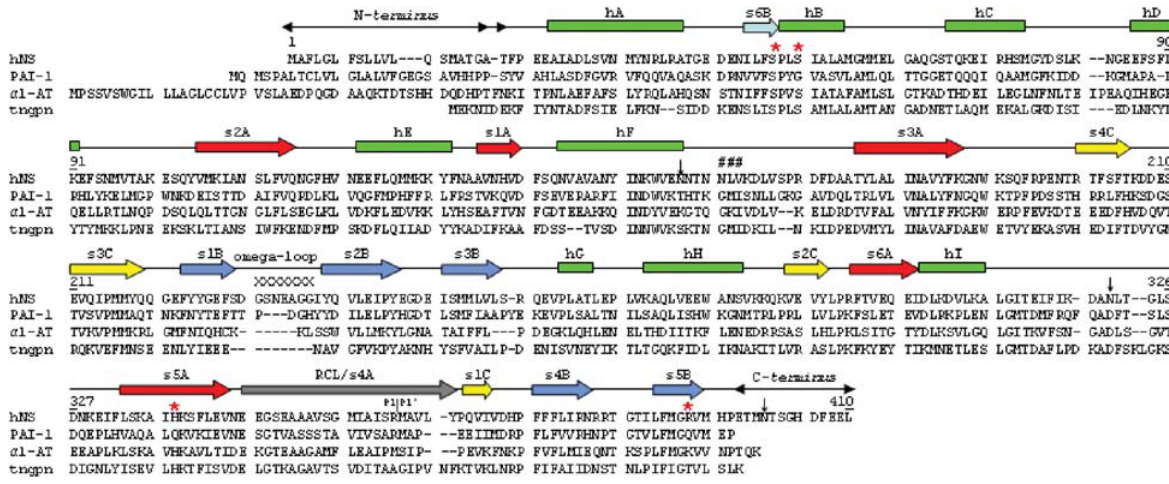
Figure 3 Sequence alignments of human neuroserpin (hNS), plasminogen activator inhibitor-1 (PAI-1), a 1-antitrypsin ( a 1-AT) and tengpin (tngpn) from the extremophile Thermoanaerobacter tengcongensis . Sequence numbering is based on hNS (15). The following residues are highlighted: N- and C-terminal peptides are marked with a two-headed arrow above the sequence; the ‘omega loop’ (from Gly231 to Ala237) is highlighted by a black X; the putative N-glycosylation sites (Gln157, Gln321, Gln401) by black arrows; residues 161–163 (NLV) by a black (cid:3) ; residues whose mutation cause FENIB (Ser49, Ser52, His338, Arg392) by red stars. ‘h’ and ‘s’ represent helices and strands, respectively. The A-, B- and C-sheets are colored red, blue and yellow, respectively; the helices are green and coil regions including the RCL are colored gray (secondary structures are color-coded as in Figure